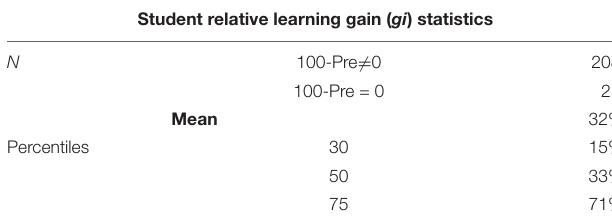
TABLE 6 | Students relative learning gain ( gi ) statistics for the second